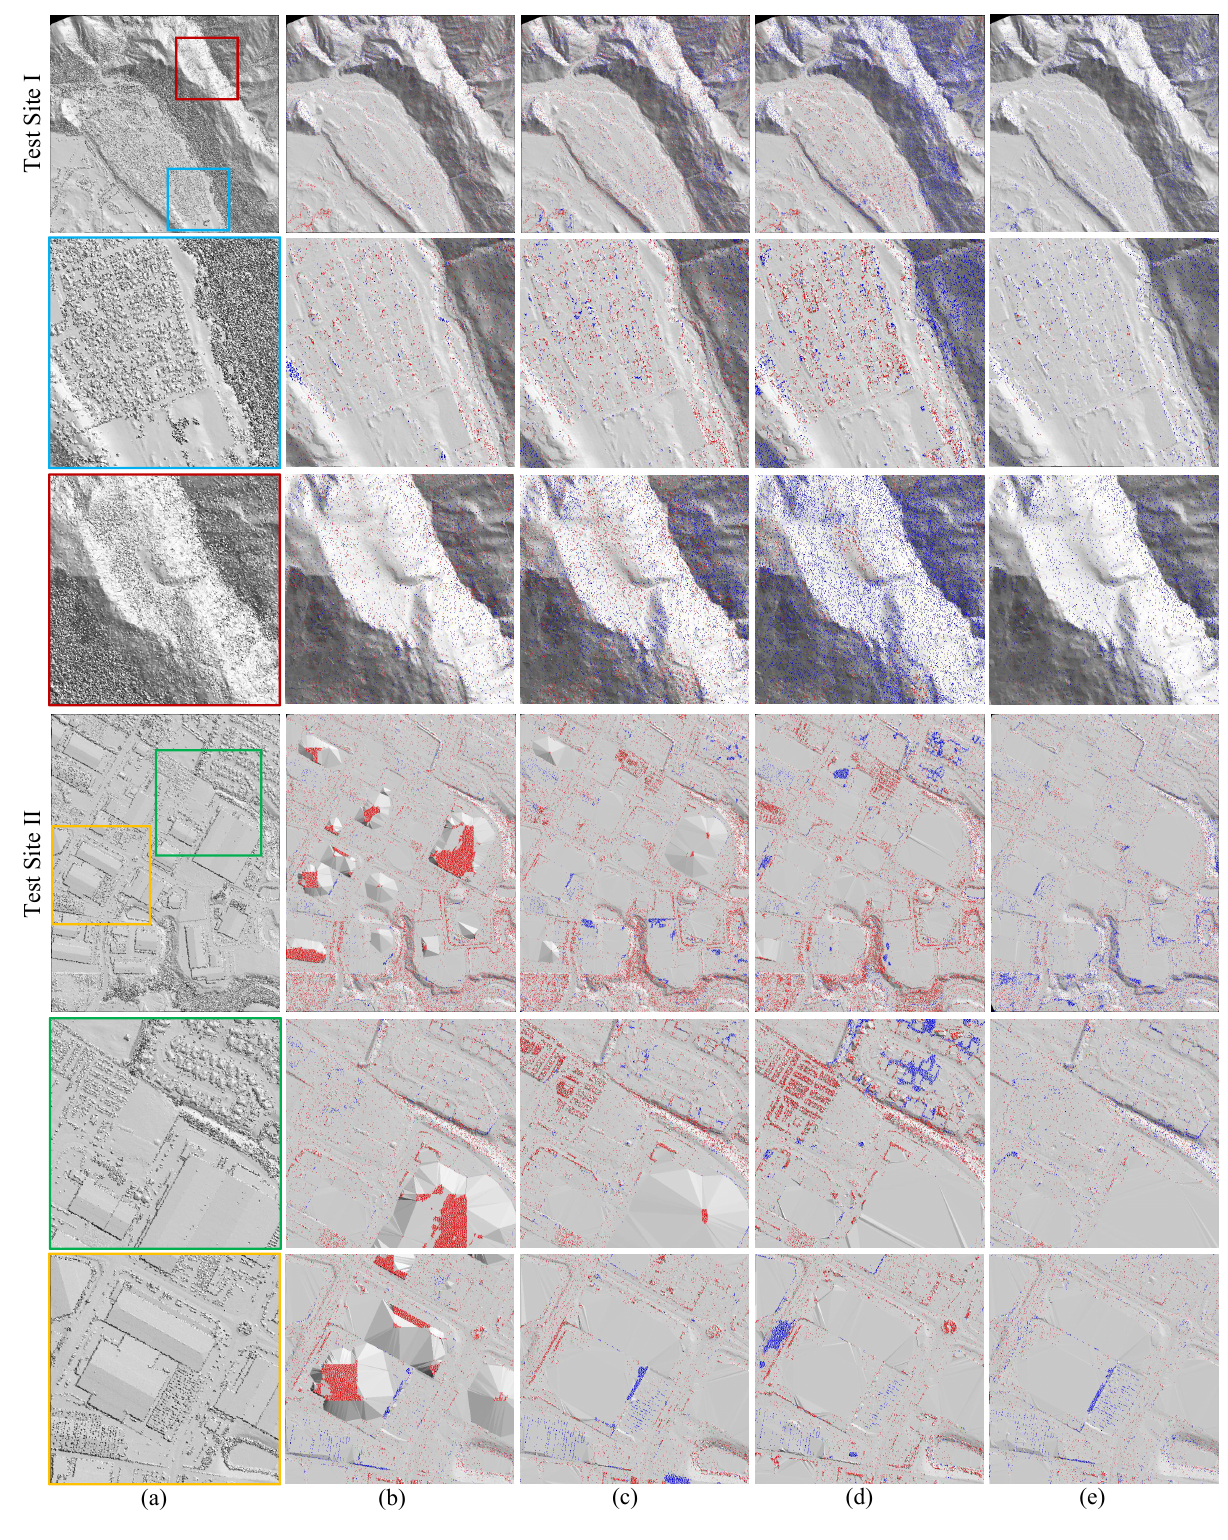
Figure 6. Visualization of MinkowUnet34C-based segmentation methods under different